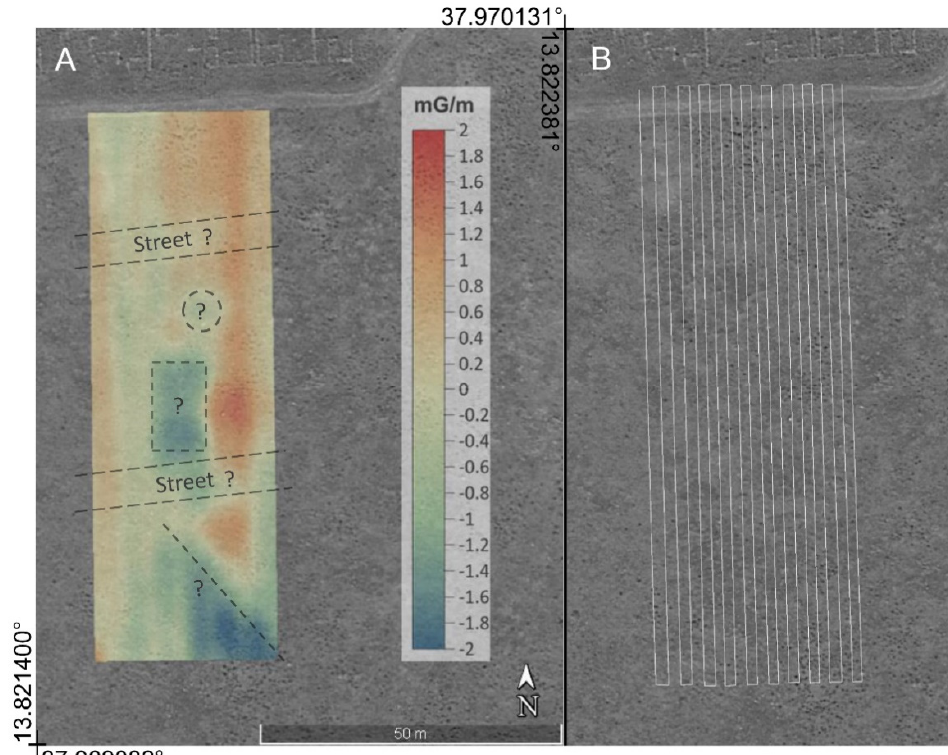
Figure 10. ( A ) Overlay of the map of the residual magnetic anomaly with an aerial Google Earth image. The line, circle, and square dots indicate supposed buried archaeological ruins. ( B ) The path of the performed mission follows N-S oriented tracks spaced 2 m. Units in milligauss/m.